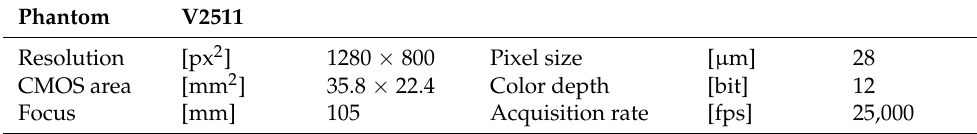
Table 2. High-speed camera